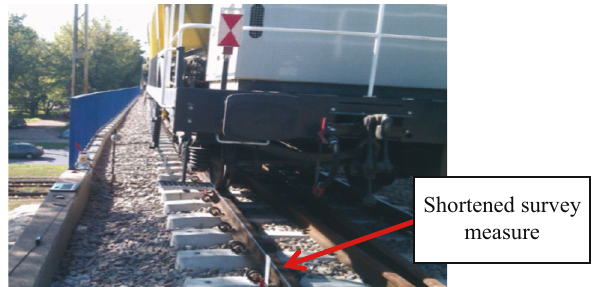
Figure 4: Geodesic measurements of rail de fl ections under a ballast - carrying wagon.